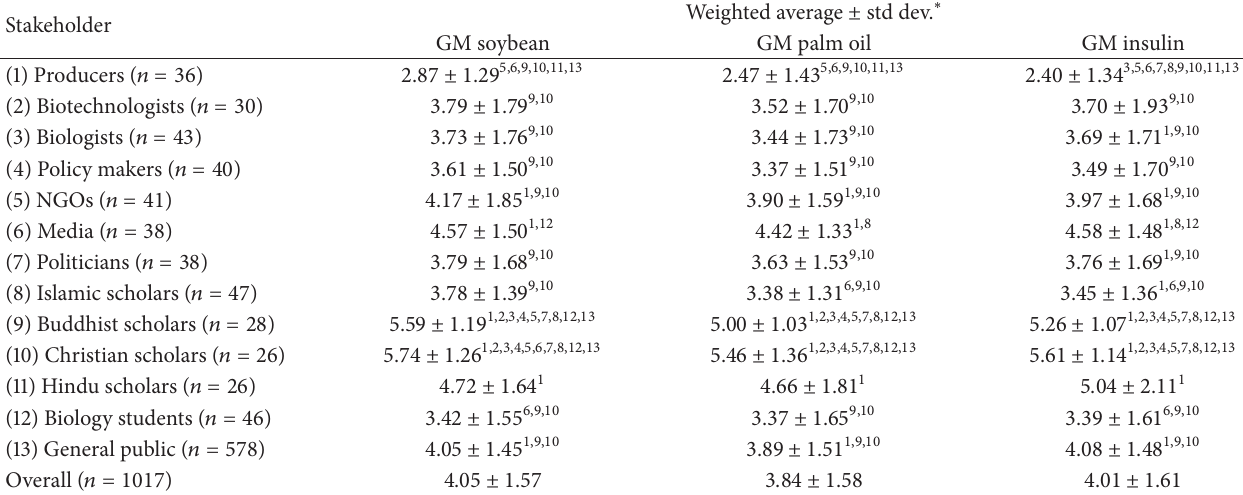
Table 8: Weighted average and post hoc test results for moral concerns of GM foods and GM insulin.